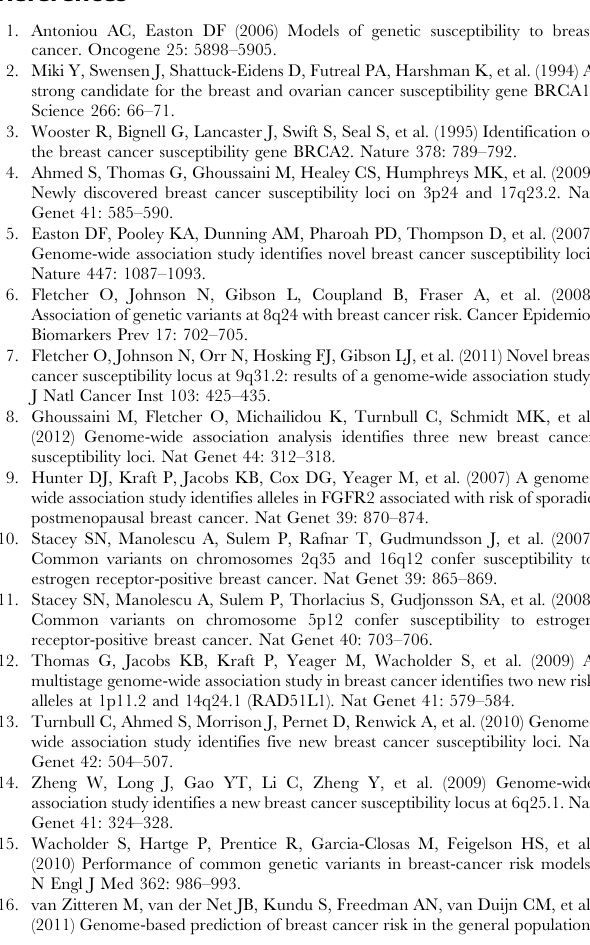
Table S6 The same groups and background list were run using 2 online GO enrichment tools, GOrilla and DAVID. The enriched terms printed in red reach best significance, as determined by an adjusted P-value , 0.05 (FDR adjust in GOrilla, Benjamini- Hochsberg adjust in DAVID).